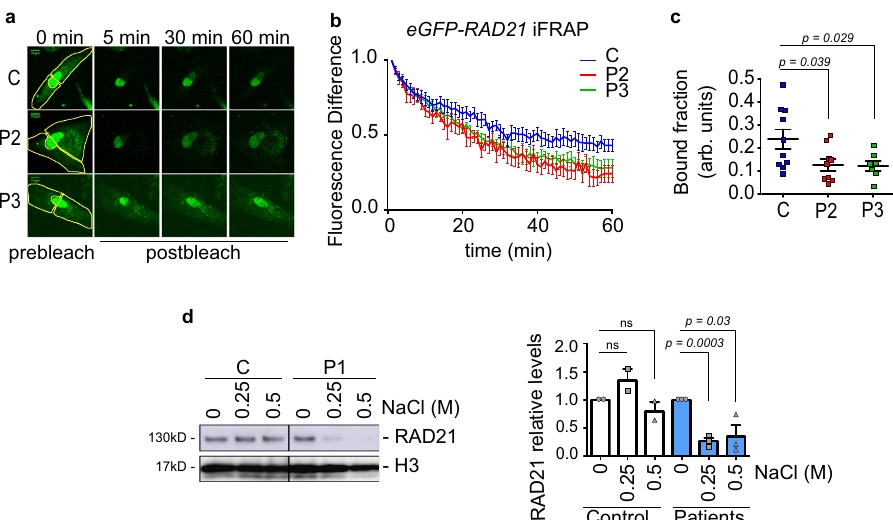
Fig. 2 Chromatin-bound cohesin is less stable in CdLS-derived cells. a Representatives images of an iFRAP experiment of control (C) and two CdLS patients (P2 – 3) cells before (0 min) and 5, 30, and 60 min after photobleaching (green channel). The entire cell, except for a small nuclear region, was photobleached (yellow line) and the fl uorescence of EGFP-RAD21 redistribution in the bleached and unbleached regions was followed by time-lapse microscopy. b Fluorescence recovery after bleaching was quanti fi ed as the difference between bleached and unbleached nuclear regions over 1 h in one control (C, blue) and two CdLS patients (P2, red; P3, green) and normalized to the fi rst post-bleach frame after 2 min. Means and SEMs are shown. Control, n = 10; P2, n = 8; P3, n = 7 cells examined over more than 3 biologically independent experiments. Two-sided unpaired student ’ s t -test. c The drop in mean fl uorescence intensity in the unbleached region at the fi rst post-bleach frame was used to calculate the chromatin-bound fraction. Same cells than in ( b ) were used. Means and SEMs are shown. Two-sided unpaired student ’ s t -test. d Chromatin fractions were prepared from cells derived from control (C) and CdLS patient (P) derived cells and washed with 0.25 and 0.5 M of NaCl containing buffer for 30 min. The amount of RAD21 bound to the chromatin was analyzed by immunoblotting. A representative experiment is shown (left panel), in which histone3 (H3) was used as a loading control. Plots of RAD21 levels in controls (white) and 3 biologically independent samples (CdLS patients P1, P2, and P3, blue) are depicted (right panel). Means and SEMs are shown. Two-sided unpaired student ’ s t